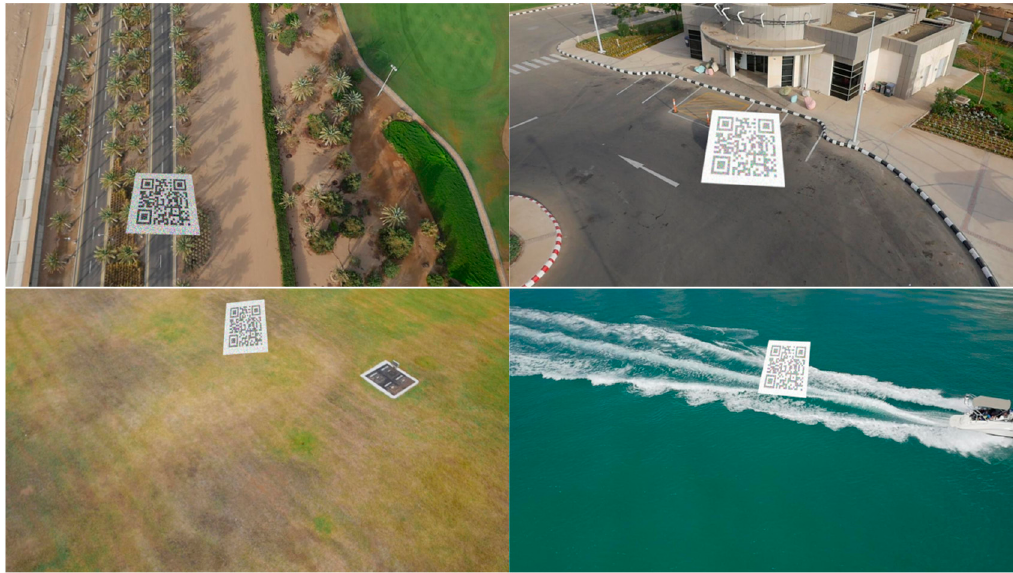
Figure 12. Images from dataset D 5p obtained by superimposing QR tags on UAV123 images, and the background of UAV123 data set is clean